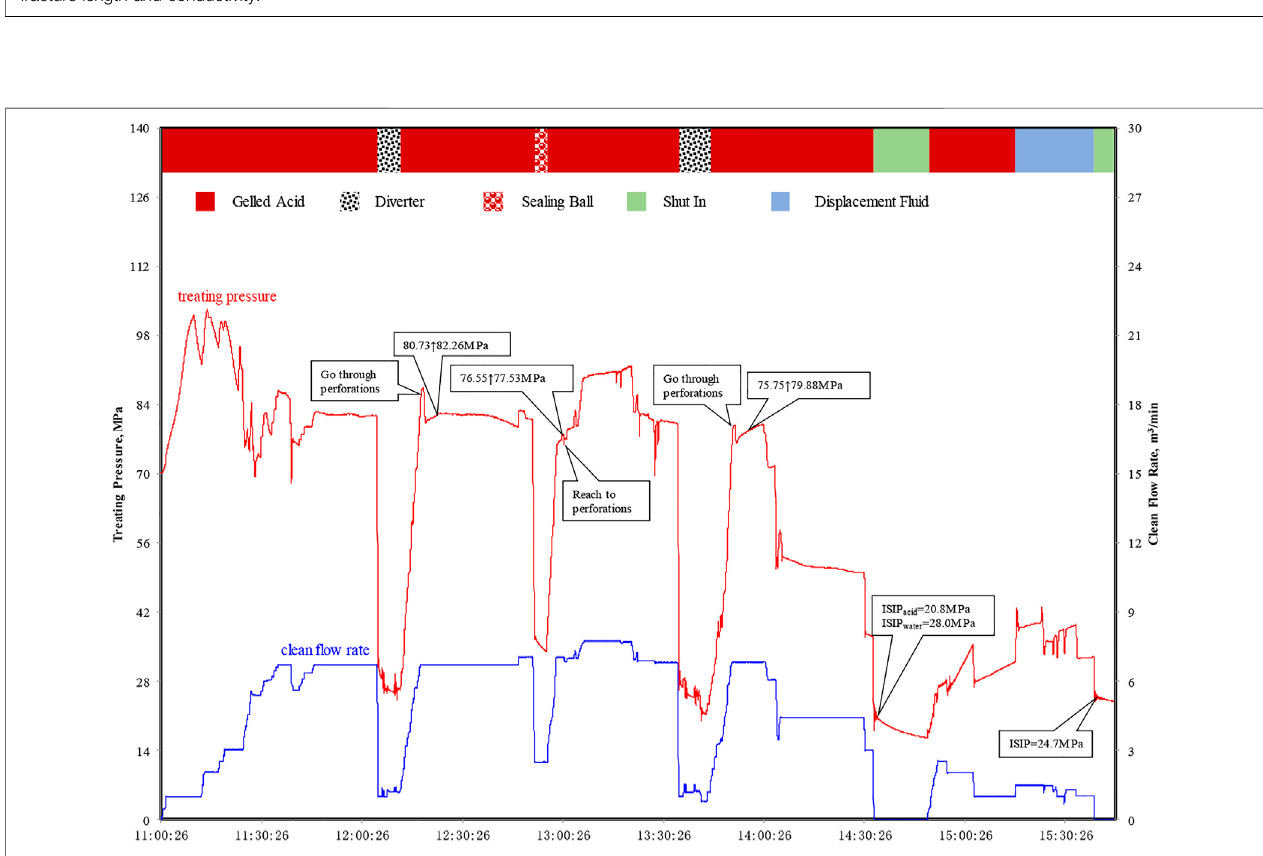
FIGURE 10 | Temporary plugging staged acid fracturing with the closed fracture acidizing operation curve of well X.